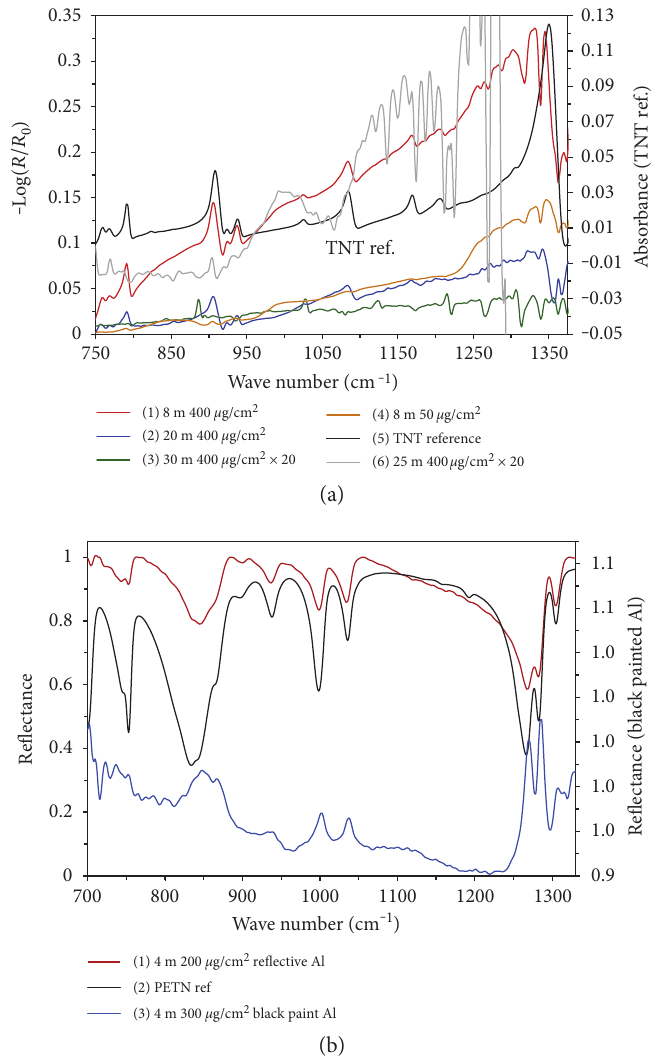
Figure 3: (a) Active mode RIRS spectra of TNT deposited on an Al plate measured at 8, 20, 25, and 30m and surface concentrations of 400 μ g/cm 2 ((1), (2), (3), and (6)) and 50 μ g/cm 2 (4), respectively. (b) Active mode RIRS spectra of PETN deposited on Al plate and black painted Al at 4